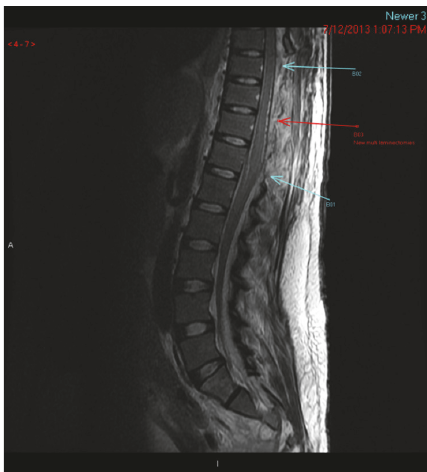
Figure 2: Image of SEA